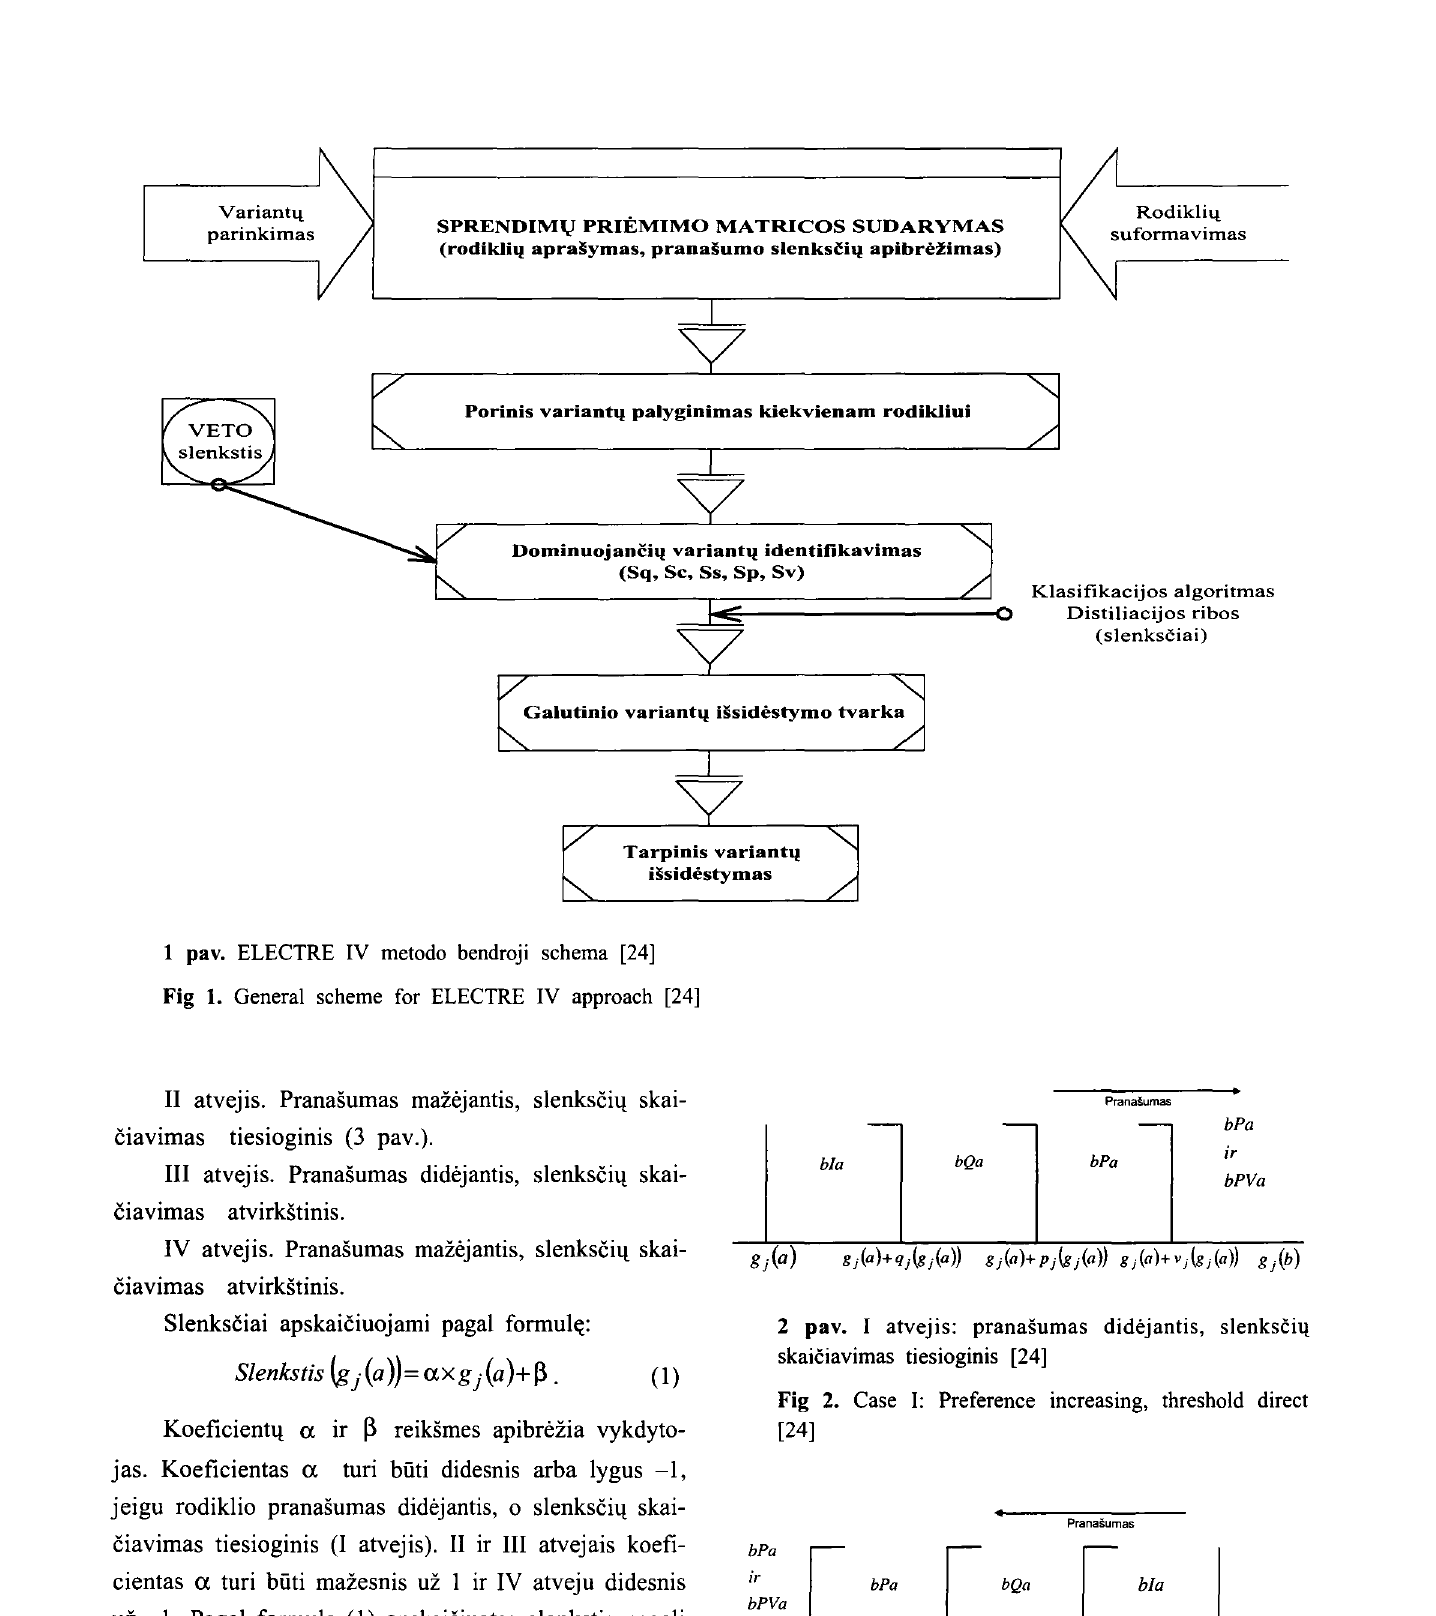
Fig 2. Case I: Preference increasing, threshold direct